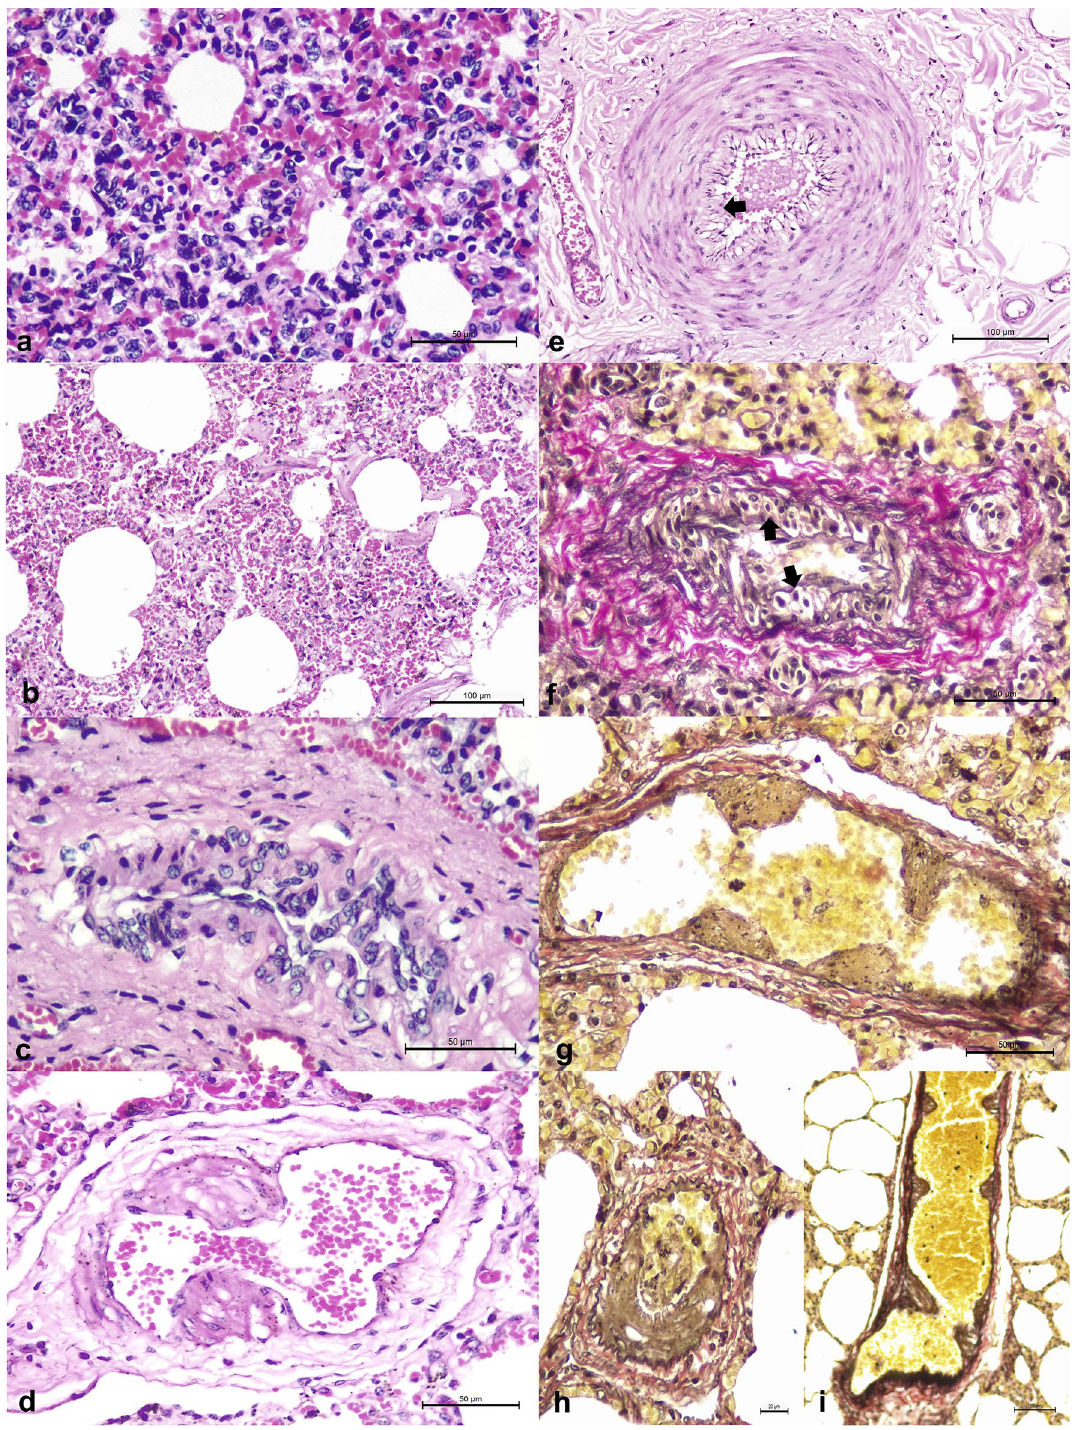
Figure 1. Histopathological and histochemical findings observed in cattle during an outbreak of respiratory disease induced by OvGHV2. Observe interstitial pneumonia in the calf ( a ) and cow ( b ), proliferating vascular lesions in the calf ( c ) and the cow ( d ) and marked endothelial degeneration (arrow) in the cow and calf ( e , f ). Observe the proliferative vascular lesions ( g , h ), with evidence of partial luminal obliteration ( i ). Hematoxylin and eosin stain ( a – e ); the Verhoeff-Van Gieson histochemical method ( f – i ). Bar; ( a , c , d , f , g ) 50 µm; ( b , e ) 100 µm; ( h , i ) 20